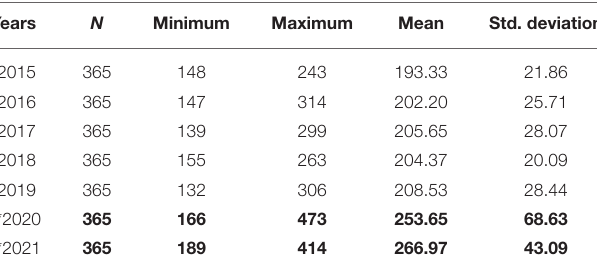
TABLE 1 | The average number of daily deaths in Istanbul during pre-pandemic * and post-pandemic ** years.